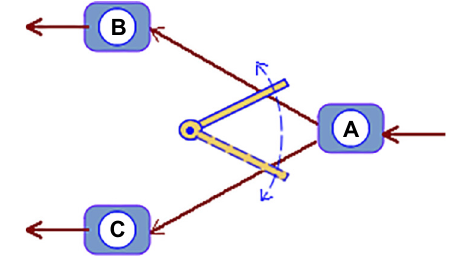
Figure 3. Multiple output